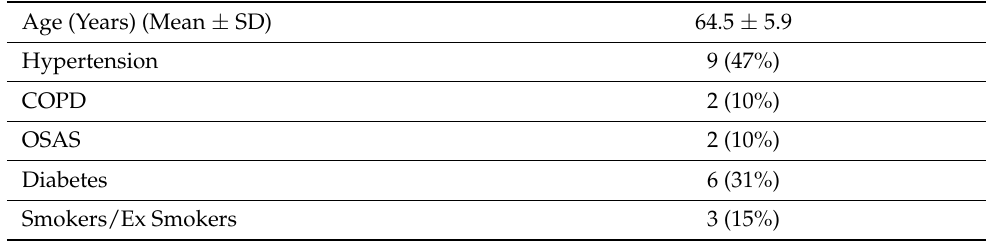
Table 1. Patient characteristics (comorbidities).